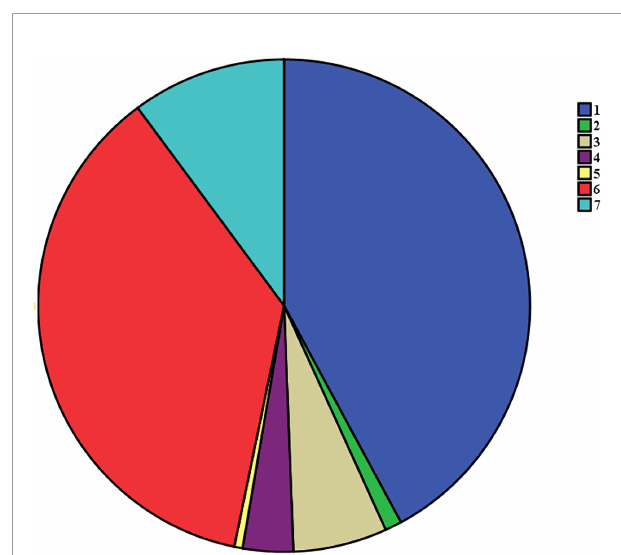
FIGURE 2 | The fl ow chart of all different surgical procedures:1) ipsilateral glandular lobe + isthmus resection + unilateral central compartment lymph node dissection; 2) ipsilateral glandular lobe + isthmus resection + unilateral central compartment lymph node dissection + lateral neck area dissection; 3) total thyroidectomy + unilateral central compartment lymph node dissection + lateral neck area dissection; 4) total thyroidectomy + bilateral central compartment lymph node dissection + unilateral neck area dissection; 5) total thyroidectomy + bilateral central compartment lymph nodes dissection + bilateral neck area dissection; 6) total thyroidectomy + unilateral central compartment lymph nodes dissection; 7) total thyroidectomy + bilateral central compartment lymph nodes